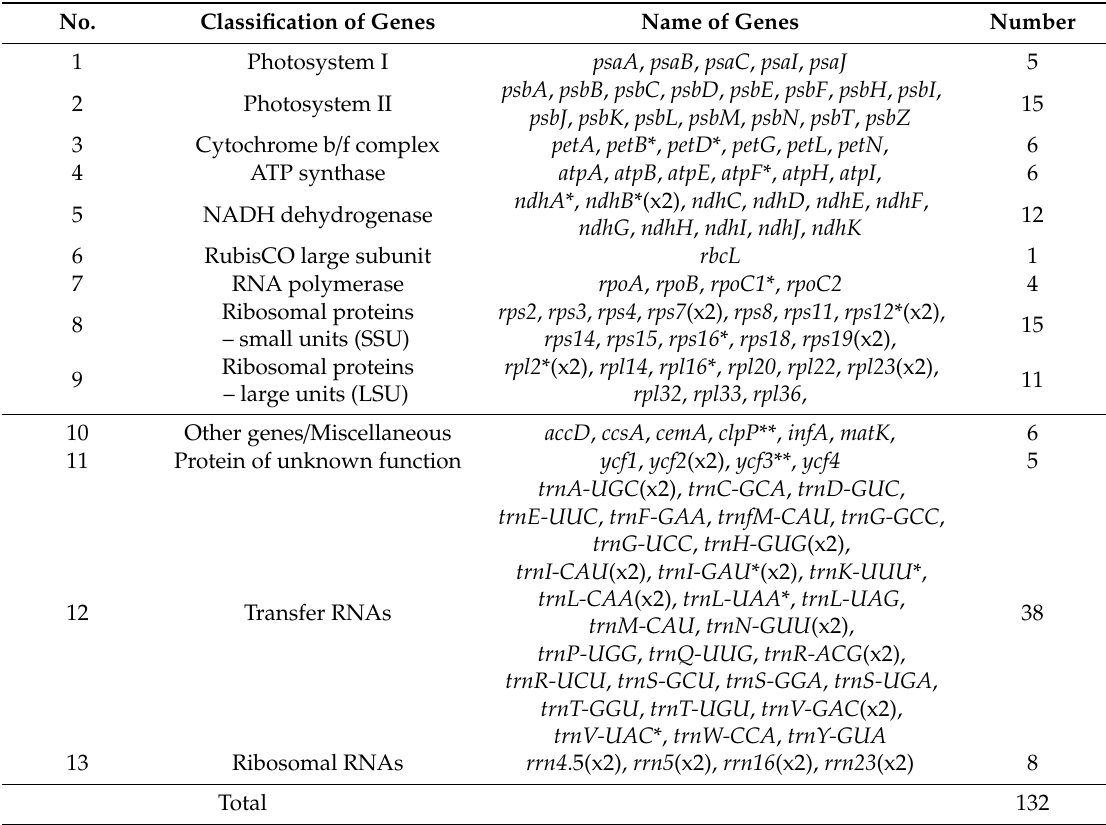
Table 2. List of genes present in the chloroplast genome of D. draco sequenced in this study.